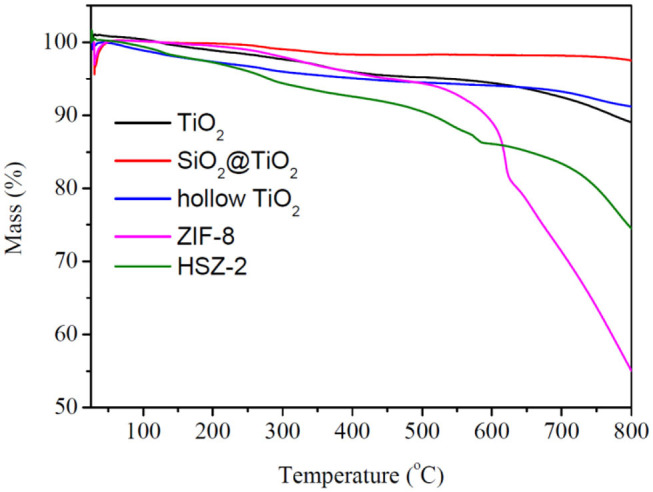
TG analysis of TiO2, core–shell SiO2@TiO2 nanoparticles, hollow TiO2 nanoparticles, ZIF-8, and HTZ-2.